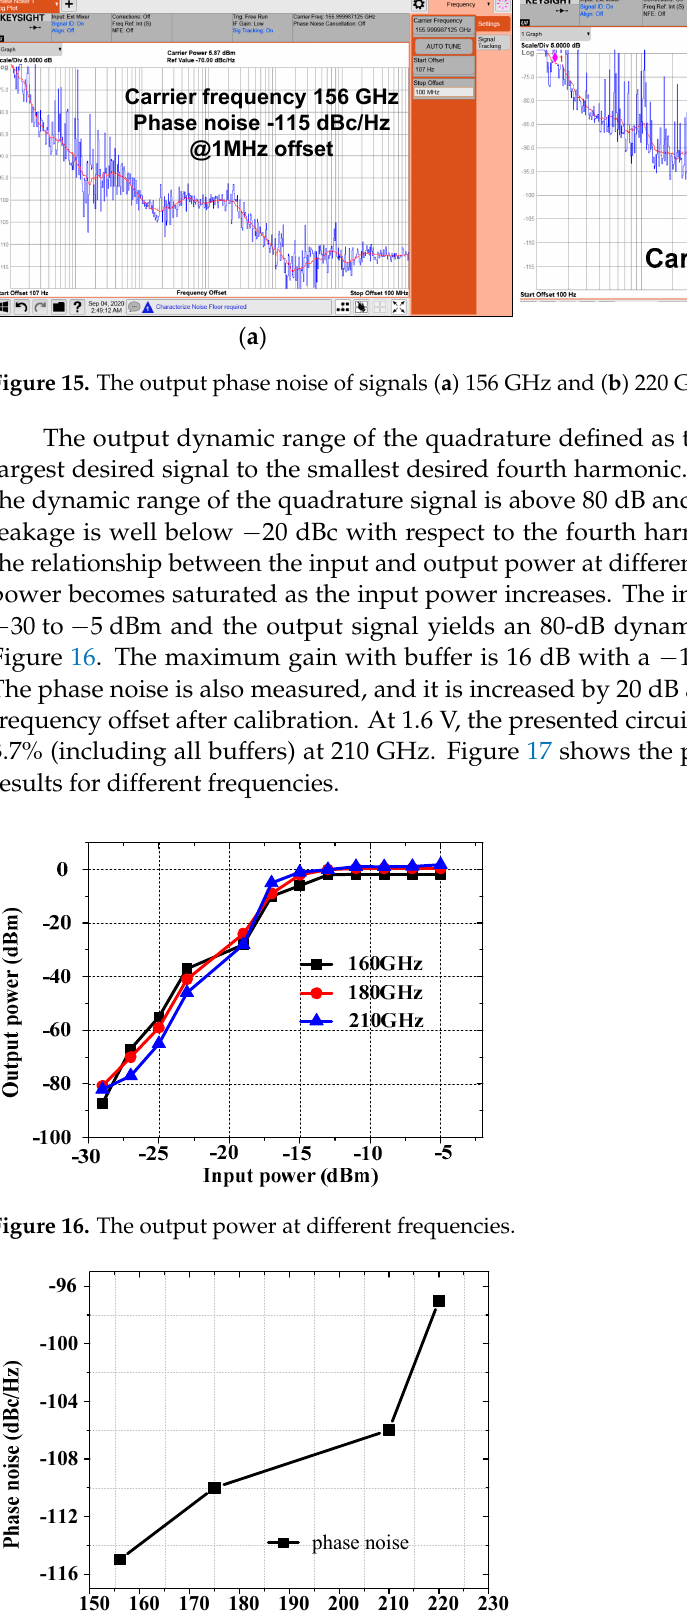
Figure 14. The output spectrum of the proposed chip ( a ) 140 GHz and ( b ) 210 GHz.